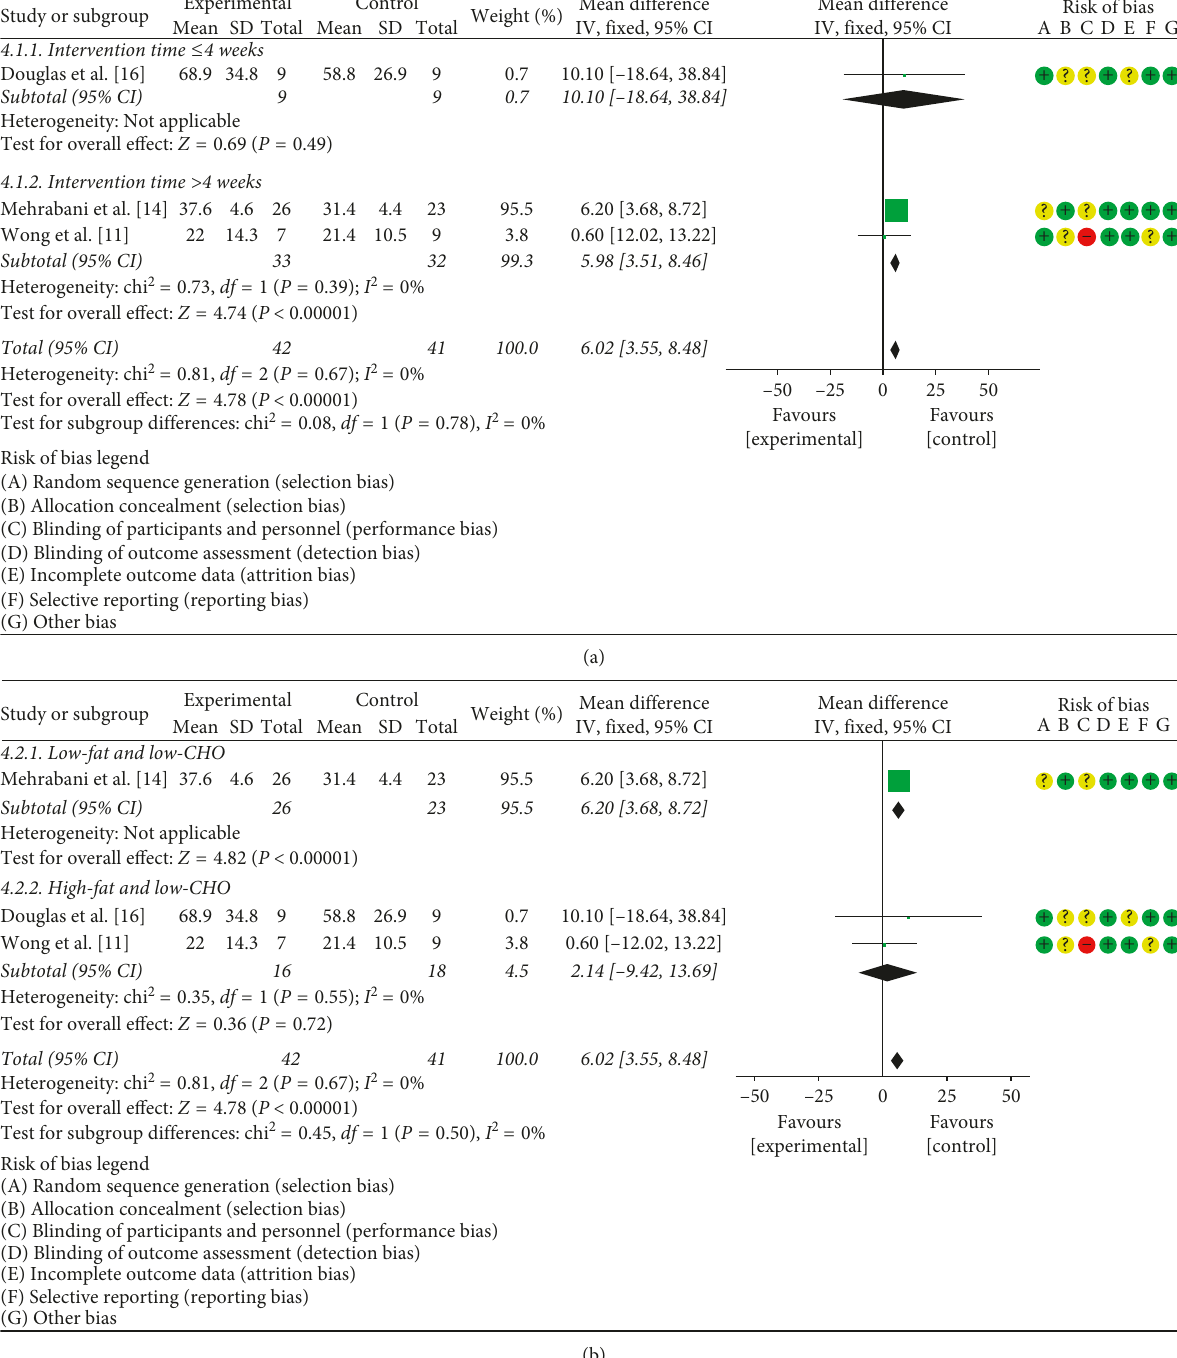
Figure 7: Meta-analysis of the effect of (a) LCD duration on SHBG levels in PCOS patients and (b) LCD type on SHBG in PCOS